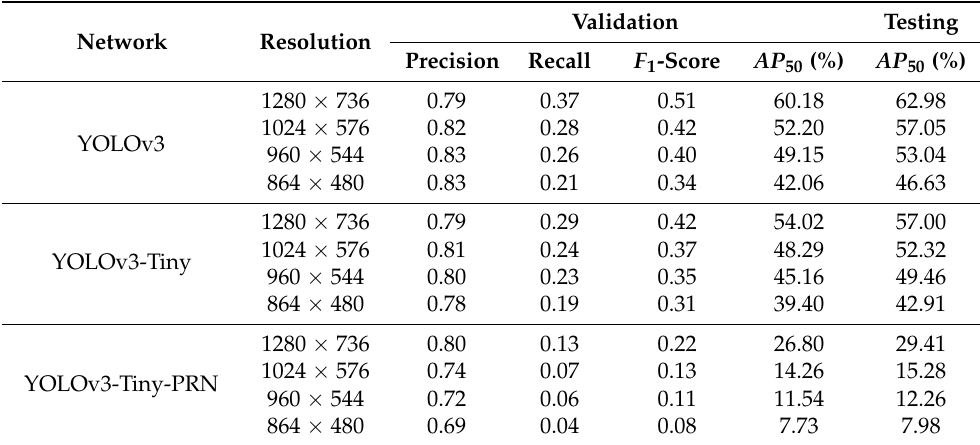
Figure 4. Examples of false negative ( left ) and false positive ( right ) hair fescue detections from spring 2019 with YOLOv3-Tiny at 1280 × 736 resolution. In the left image, several hair fescue tufts are clumped together and are not detected. In the right image, a small, bladed weed is misidentified as hair fescue. Part of a hair fescue tuft is shown directly left of the false positive detection. Table 1. Object-detection results for hair fescue plants in images of wild blueberry fields. Training and validation images Table 2. Object-detection results for sheep sorrel plants in images of wild blueberry fields. Training, were captured in spring 2019, while the testing images were captured in autumn 2019. validation and testing images were captured in spring